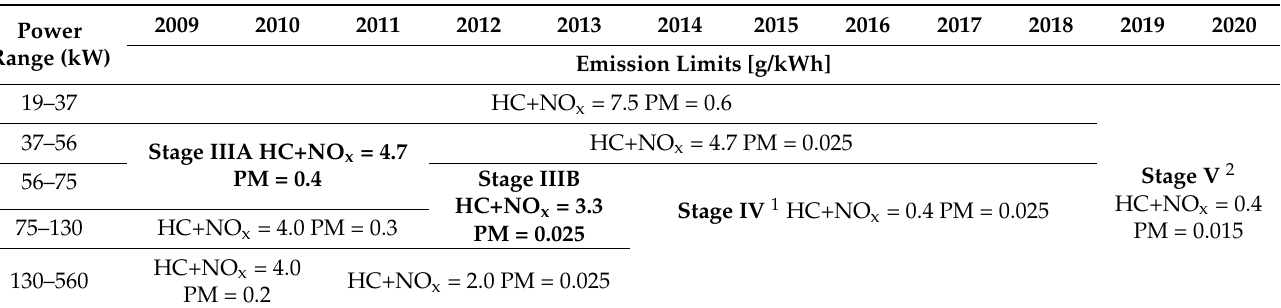
Table 1. Stage Standards in the EU, changes to emission limit values in